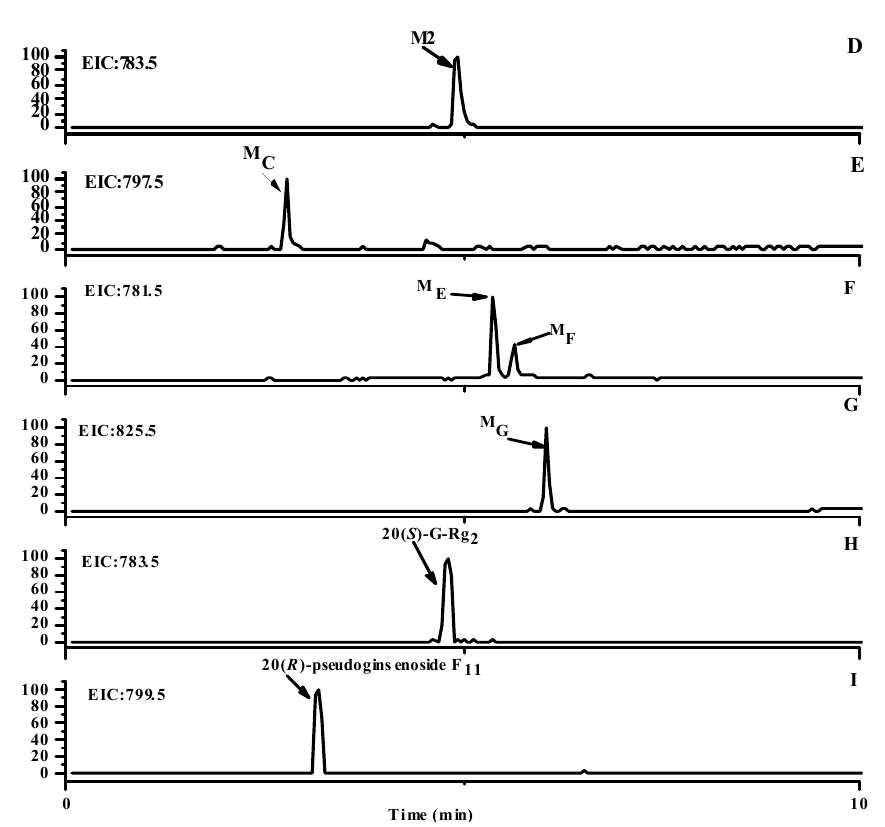
Figure 2. The typical base peak intensity (BPI) chromatograms of 20( S )-G-Rg 2 metabolites. ( A ) BPI of all metabolites; ( B ) EIC of M1 , M3 , M4 , M A and M D ; ( C ) EIC of M B ; ( D ) EIC of M2 ; ( E ) EIC of M C ; ( F ) EIC of M E and M F ; ( G ) EIC of M G ; ( H ) EIC of authentic 20( S )-G-Rg 2 ; ( I ) EIC of authentic 20( R )-pseudoginsenoside F 11 .